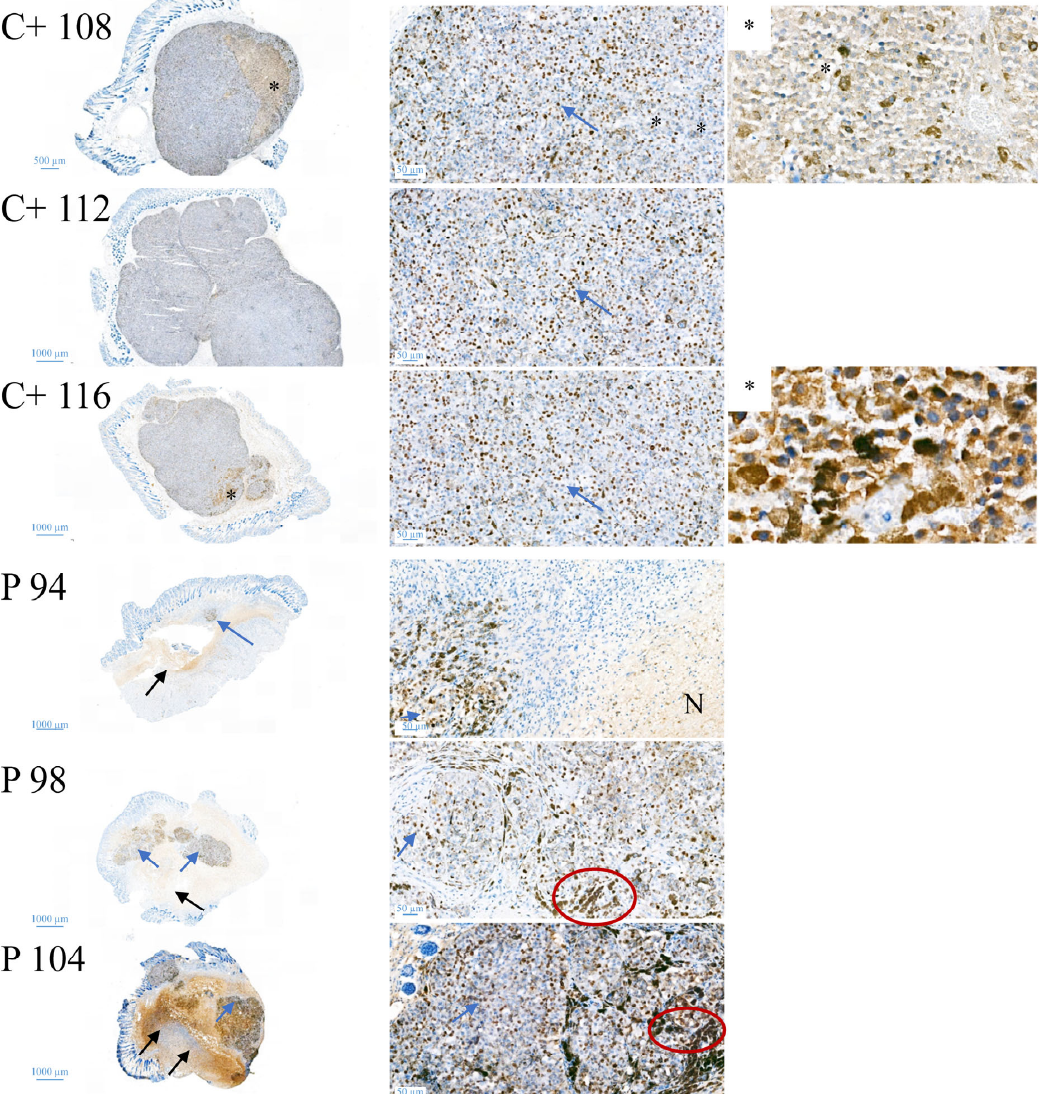
Figure 11. Changes in proliferation upon peptide treatment. For control tumors C+ 108, C+ 112, C+ 116 and peptide-treated tumors P 94, P 98 and P 104 proliferation was studied by Ki67 staining indicating besides strong reduction in tumor size also a strong reduction in proliferation of MUG- Mel2 upon treatment with RDP22. C+ 108, 112, 116: Untreaded vehicle control shows uniform vital tumor tissue, hardly any tumor necrosis (overview left image). C+ 108: High power view (right image): Specific nuclear Ki67 expression in approximately 35% of tumor cells (blue arrow); tumor area showing heavily pigmented tumor cells (*). C+ 112: High power view (right image): Specific nuclear Ki67 expression in approximately 35% of tumor cells, single cells with clear nuclear dark brown reactivity against Ki67 antibody (blue arrow); C+ 116: High power view (right image): Specific nuclear Ki67 expression in approximately 35% of tumor cells (blue arrow); tumor area showing heavily pigmented tumor cells (*). P 94, 98, 104: Areas of tumor necrosis with unspecific cytoplasmic staining (black arrows); areas with vital tumor cells partly heavily pigmented (blue arrows). P 94: High power view (right image): unspecific IHC staining in an area of tumor necrosis (N) small focus of vital tumor tissue with specific nuclear Ki67 expression in approximately 15% of tumor cells (blue arrow); P 98: High power view (right image): cytoplasmic melanin pigment in tumor cells (red circle); Specific nuclear Ki67 expression in approximately 20% of tumor cells (blue arrow); P 104: High power view (right image): cytoplasmic melanin pigment in tumor cells (red circle); Specific nuclear Ki67 expression in approximately 30% of tumor cells (blue